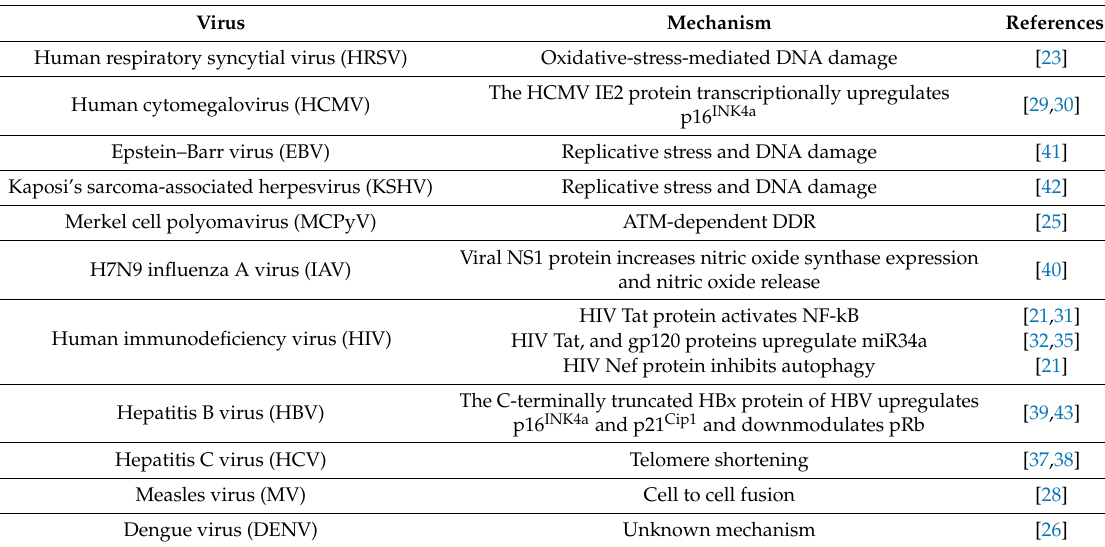
Table 1. Induction of senescence by